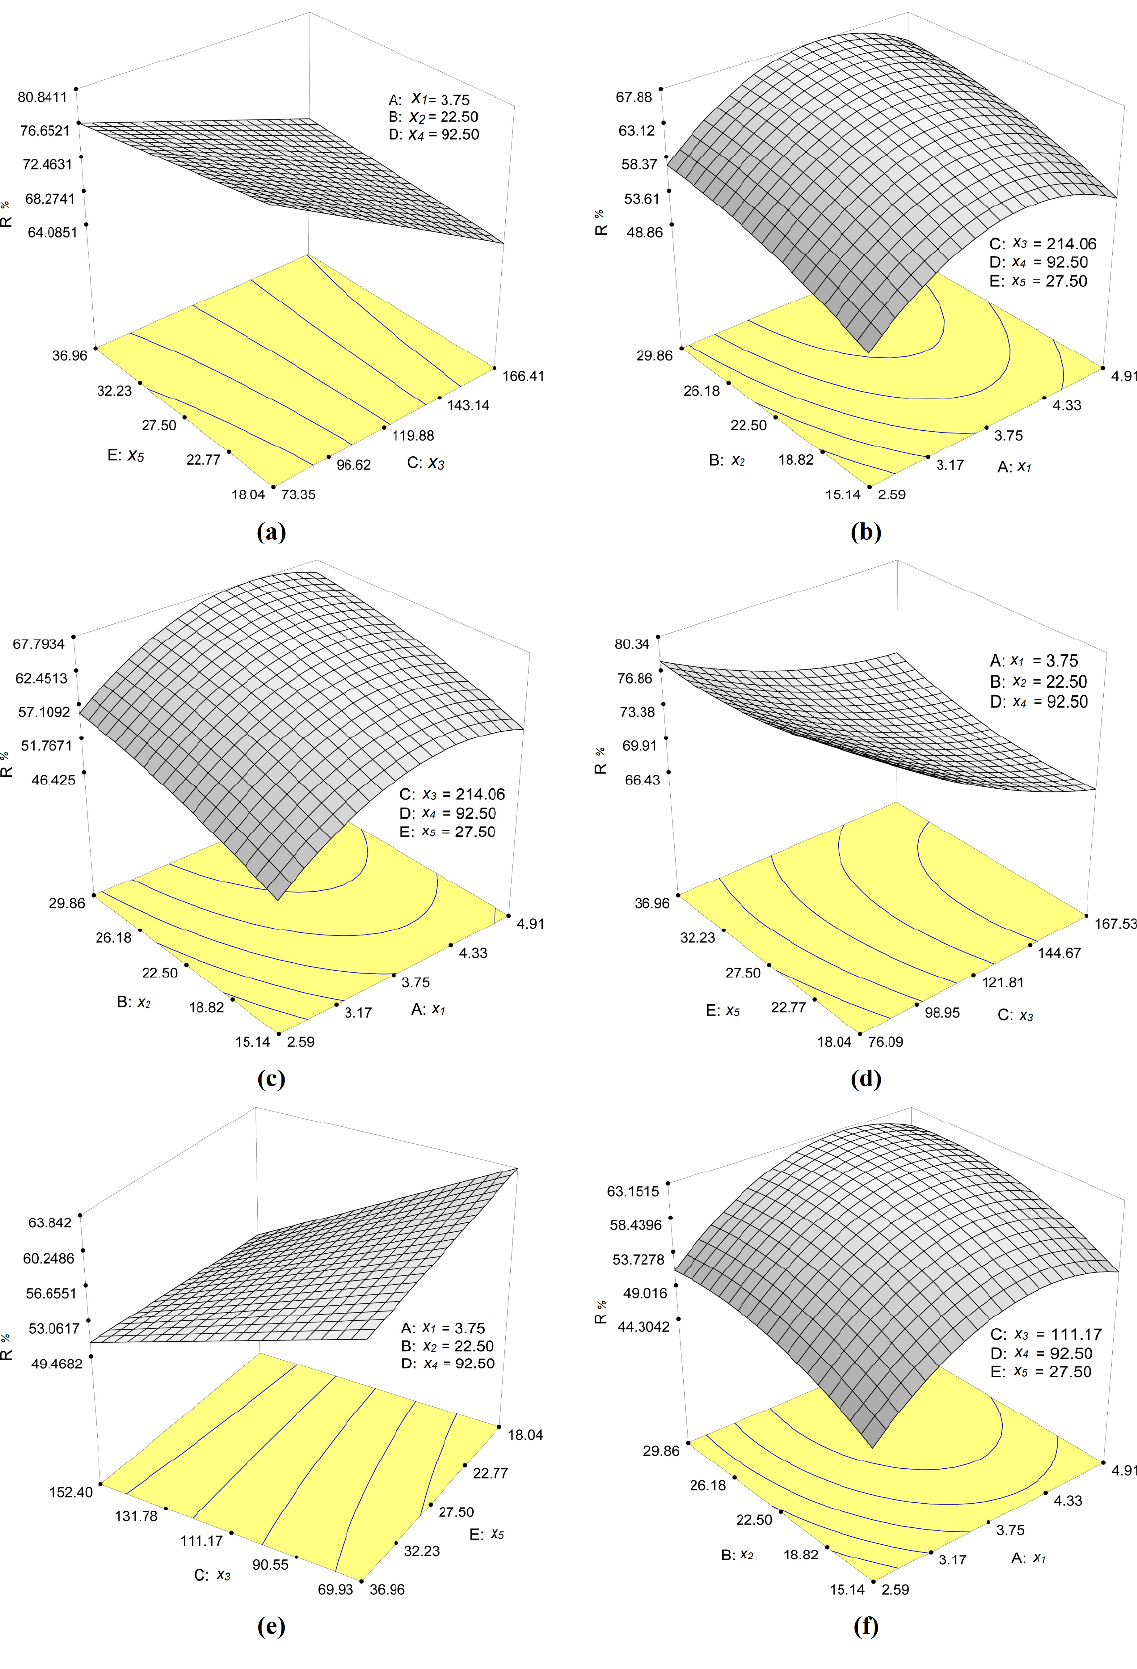
Figure 13. Response surfaces for mathematical models developed for biosorption efficiency of metal ions ( R , %) (the meaning of the notations ( a – f ) is the same as those from Figure 9).